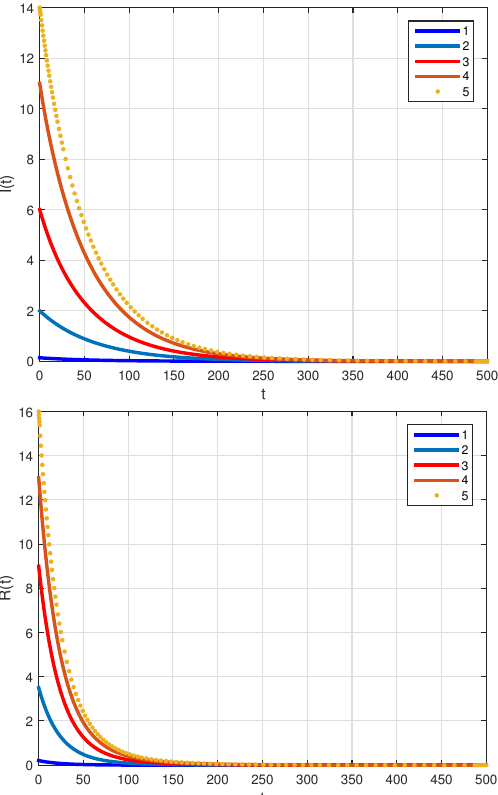
Figure 3. The evolution dynamics of infected and removed population vs. time, R 0 = 0.1087 < 1.